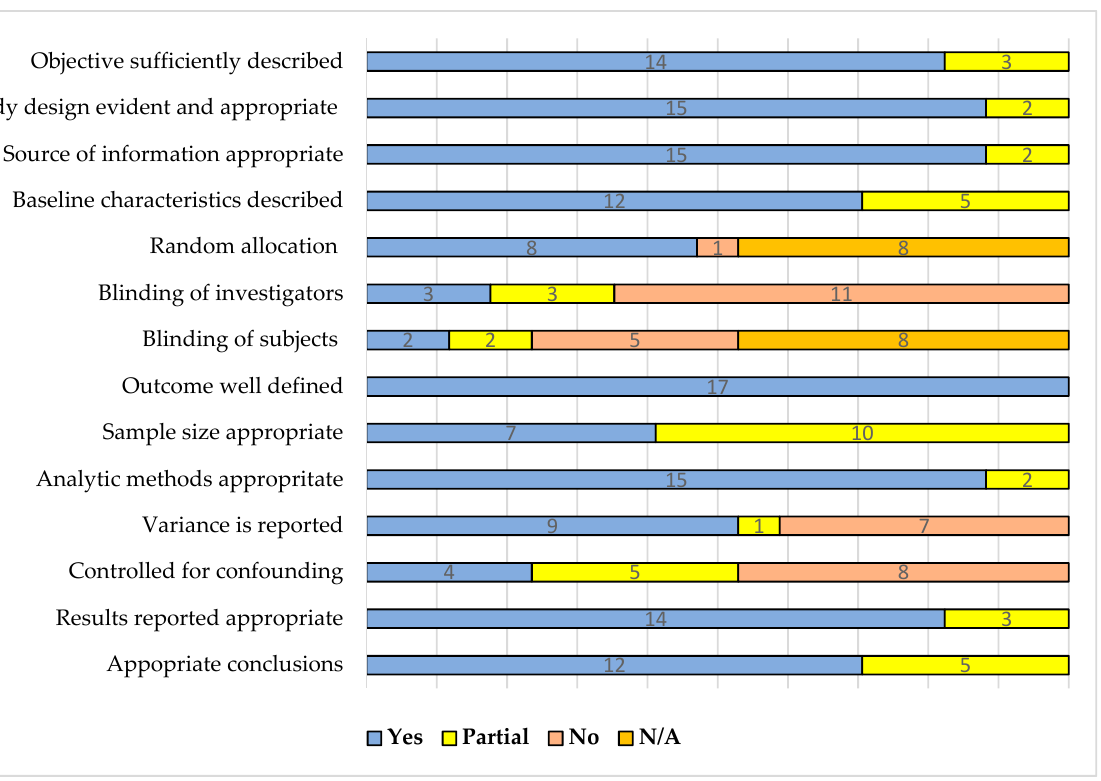
Figure 2. Summarized quality assessment of the included studies ( n = 17) using QualSyst tool.